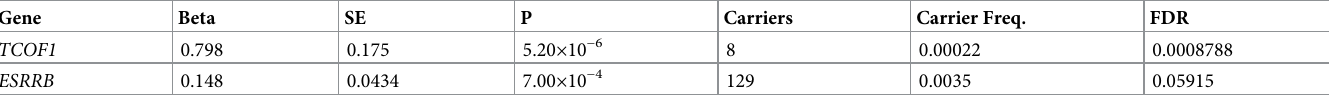
Table 3. Known hearing loss gene burden associated with degree hearing loss (FDR < 0.1) in PMBB. Gene